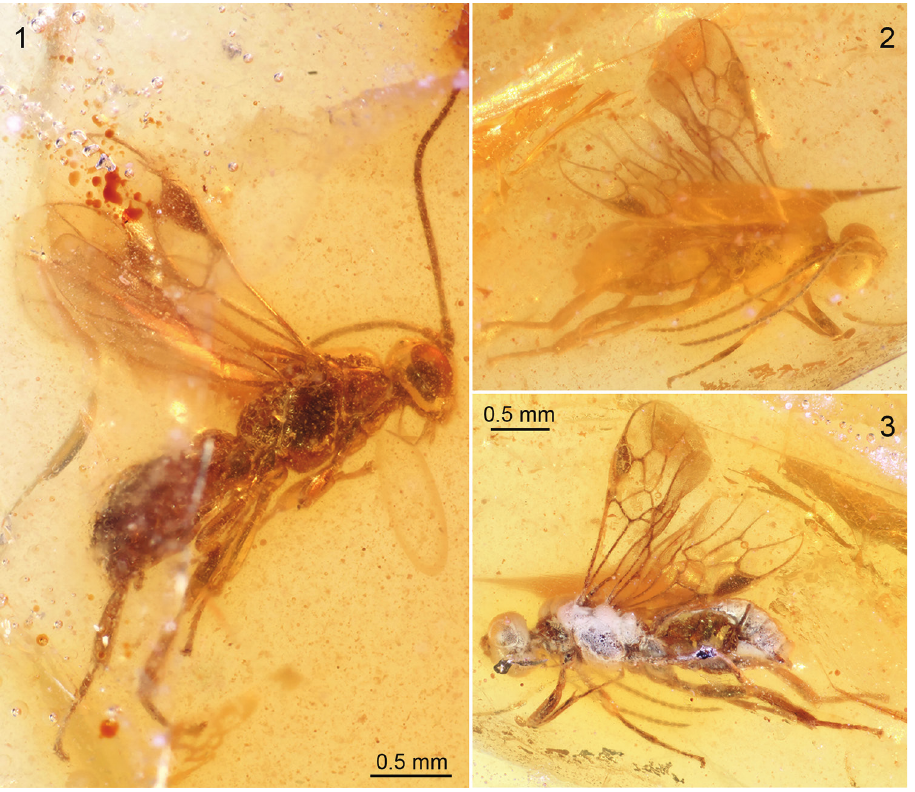
Figures 1–3. Photographs of males of Rhetinorhyssalites emersoni , gen. et sp. n., in Raritan amber. 1 Right lateral habitus of holotype (AMNH NJ-892A) 2 Right lateral view of paratype (AMNH NJ-692), to same scale as figure C 3 Left lateral view of